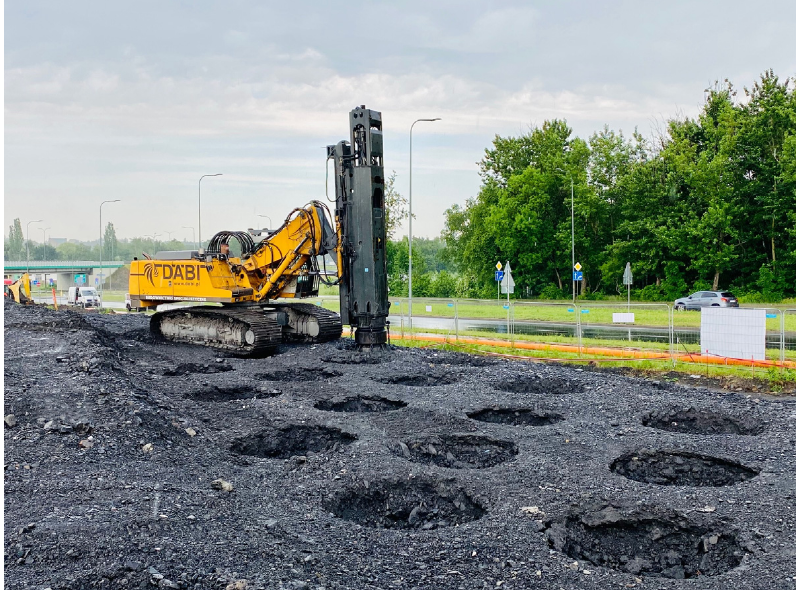
Figure 23. RIC impulse compactor in operation (Photo by P. Dobrzycki).